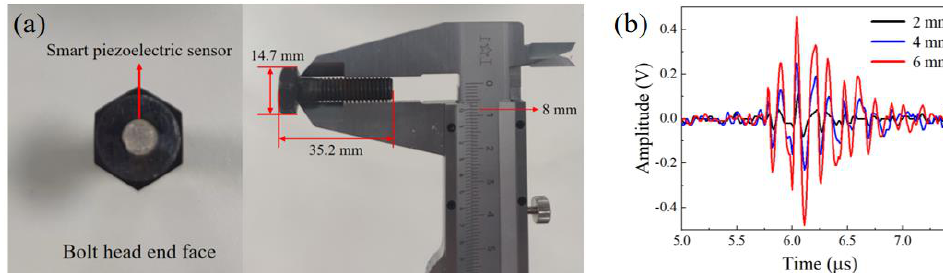
Figure 3. Schematic diagram and experimental setup of the laser ultrasonic excitation unit.